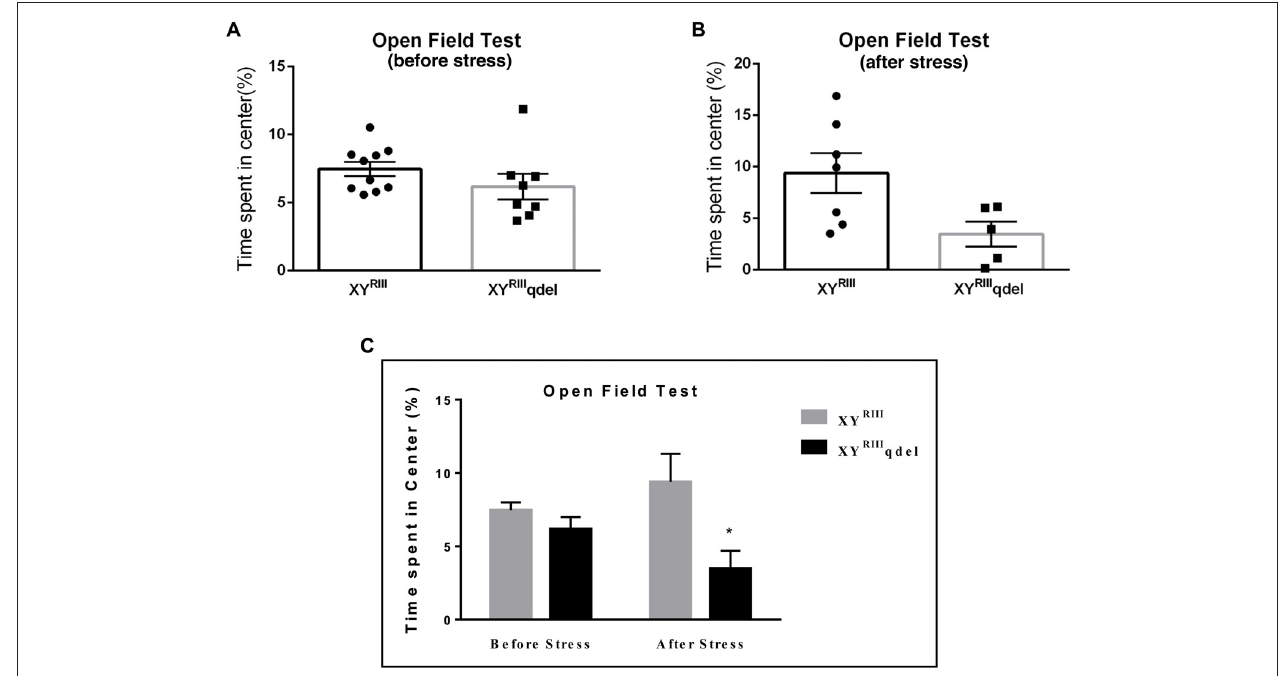
FIGURE 1 | The status of anxiety in XY RIII qdel and XY RIII mice was evaluated by open field test before and after the exposure of the stressors. Before the mice have undergone stress paradigm, the status of anxiety did not differ from the wild type as shown by scatter bar plot (A) , whereas in the same test they showed significantly more anxiety phenotype by spending remarkably less time in center on stress response (B) . Combined bar graph is shown to compare the effect of before and after stress (C) . Data are expressed as the mean ± SEM, ∗ P < 0.05, n = 8–10 per group in before stress, n = 6–8 per group in after stress